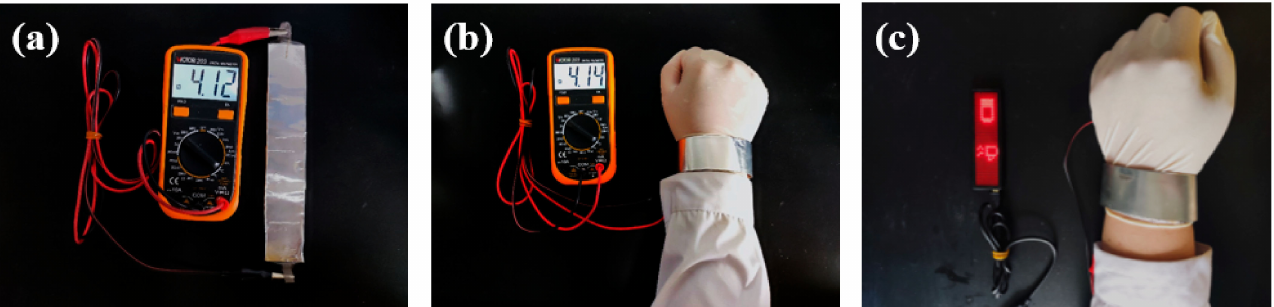
Figure 8. Flexible zinc-air battery assembly array and its application. ( a ) Array static voltage; ( b ) array flexibility; ( c ) array wear